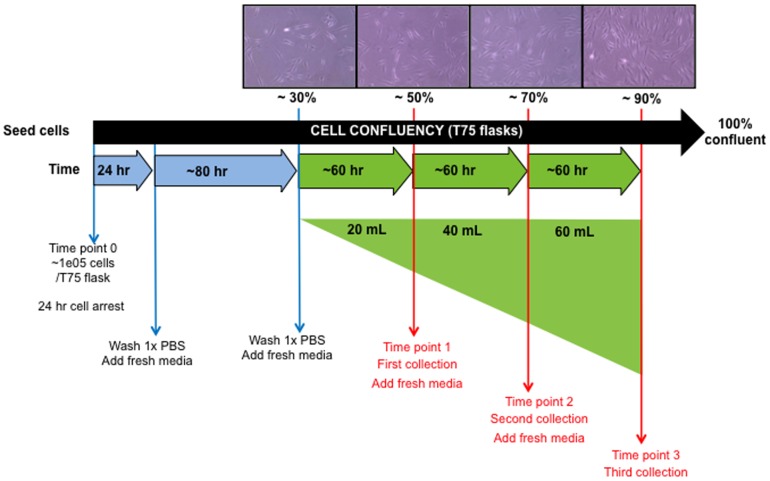
Schematic timeline for collection of primary culture conditioned media.Conditioned media was collected every ∼60 hrs when PKF (n = 5), IKF (n = 5), NF (n = 4) and NS (n = 4) were in proliferative log phase of growth. For each individual primary cell culture, conditioned media was collected at ∼50%, 70% and 90% confluency states and subsequently amalgamated prior to treatment of cells. PKF = peri-lesional keloid fibroblasts, IKF = intra-lesional keloid fibroblasts, NF = normal skin fibroblasts, NS = normal dermal scar fibroblasts.